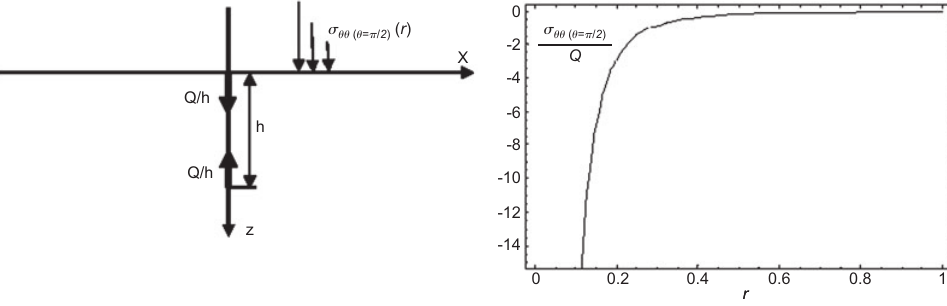
Figure A1 Schematic representation of a force couple without moment of strength Q . The plot on the right shows the normalized surface ( r ) = σ ( r , π /2) Q as a function of distance r from the point of traction t θ = π /2 θ θ